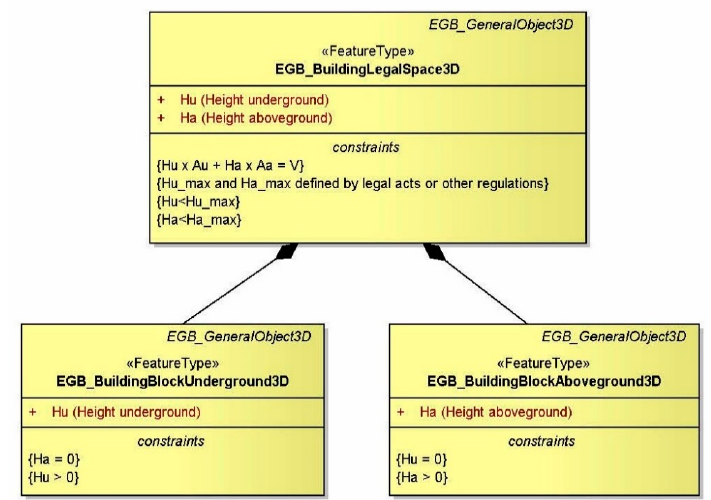
Figure 9. Three-dimensional cadastre-base model. Source: own study based on Byd ł osz [89].